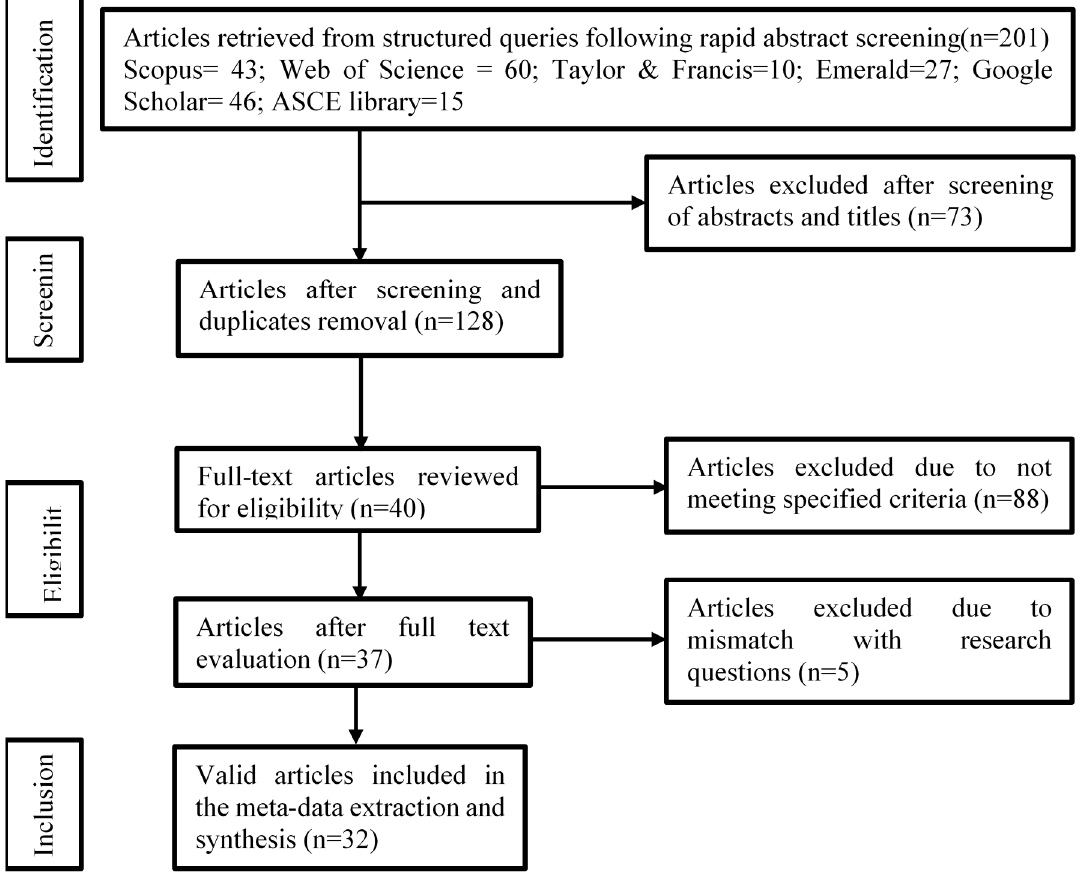
Figure 2. Article screening and evaluation protocol (adapted from Moher et al. [30]).